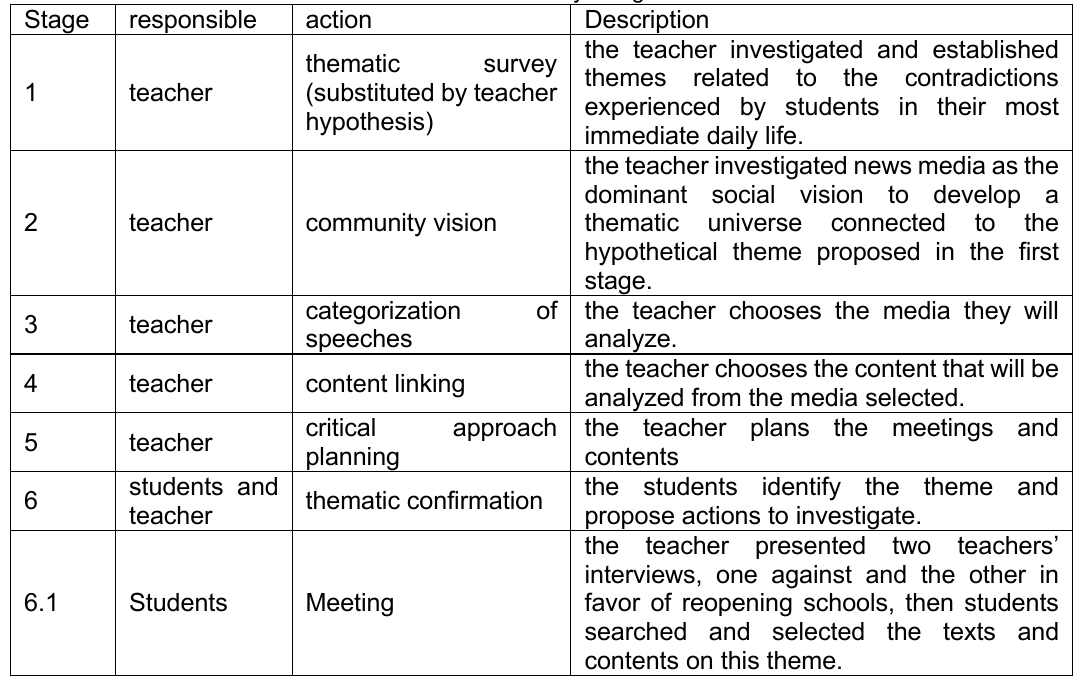
Table 1: Activity